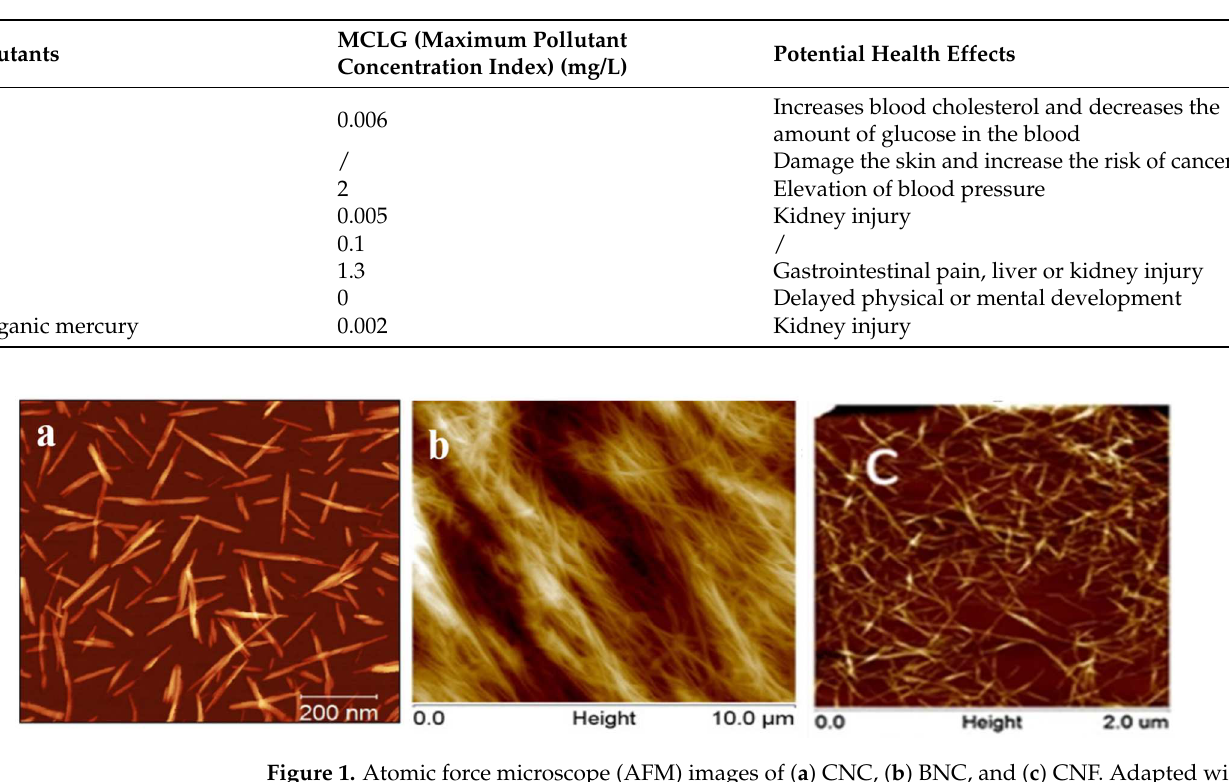
Table 1. Maximum concentrations and hazards of heavy metal ions in drinking water, data from US EPA.